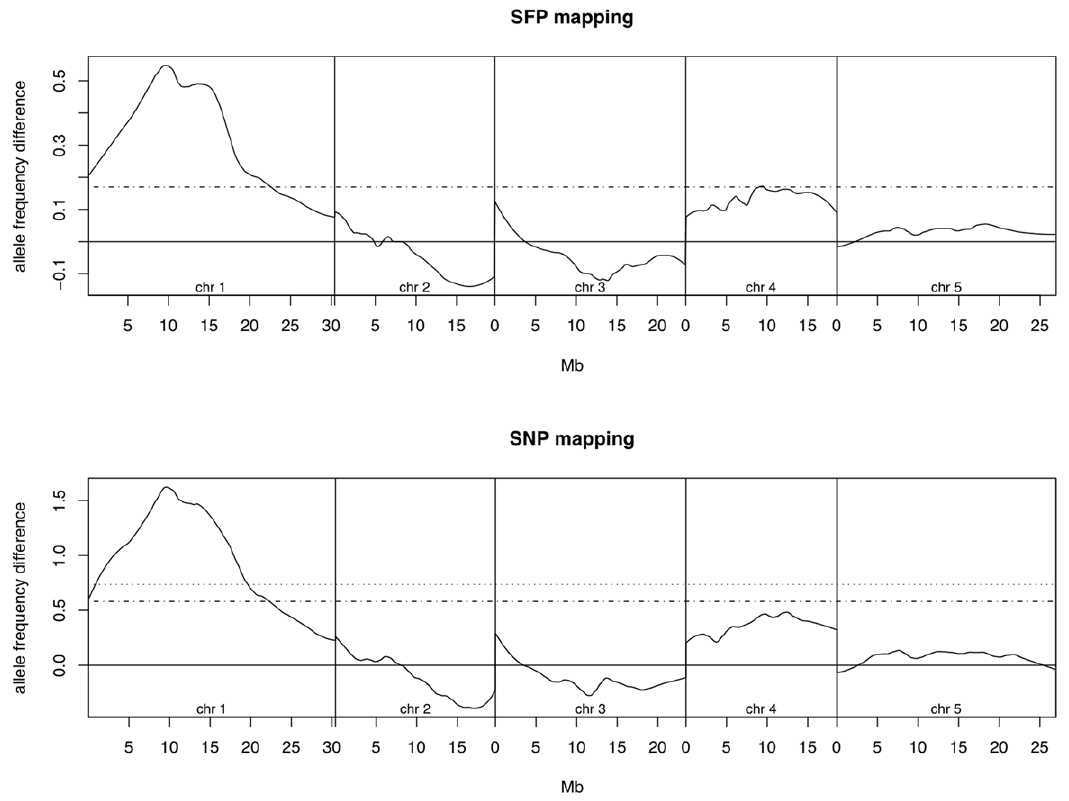
Figure 3. BSA using SNPs vs. SFPs. A comparison of BSA with SFP genotyping vs. BSA with SNP genotyping using the same genomic DNA for hybridization. A. The dashed line represents the detection threshold of 0.17 established by Borevitz et al . [3]. B The dashed lines represent the 95 and 99% confidence thresholds for detection established by our simulations.